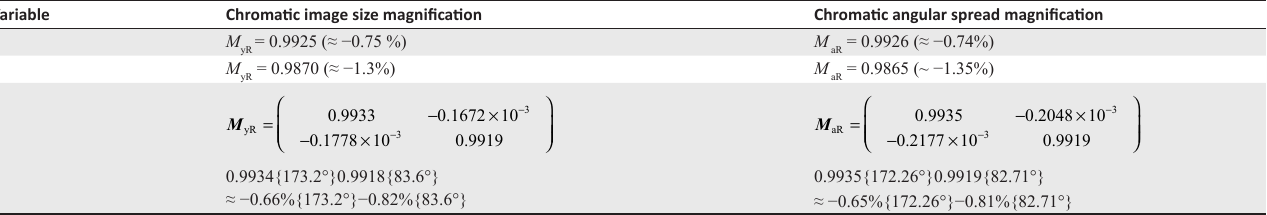
FIGURE 2: A general eye with corneal T trace only the red and blue rays traversing the same position in the pupil y image of size ∆ Rr y to the blue image of size ∆ Rb y in T inclinations, object and image sizes, and pupil decentration are exaggerated for clarity. TABLE 3: Chromatic magnification. Variable Chromatic image size magnification Chromatic angular spread magnification